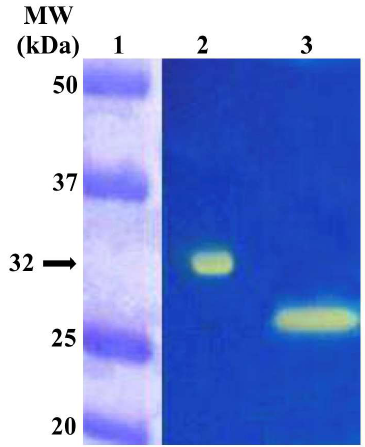
Figure 5. Protonography of the overexpressed recombinant SpiCA3 purified from the BL21 (DE3) cell extract using the His-select HF Nickel affinity column. The yellow band corresponds to the hydratase activity position on the gel. Lane 1, molecular markers; Lane 2, purified recombinant SpiCA3; Lane 3, commercial bovine CA used as positive control.